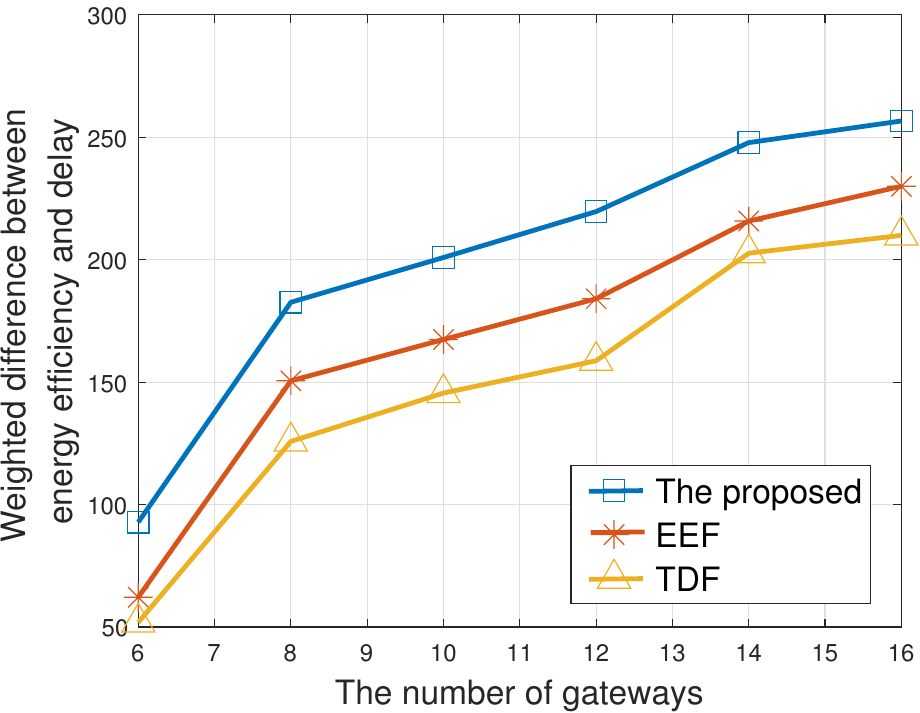
Figure 3. Weighted difference between energy efficiency and delay versus the number of